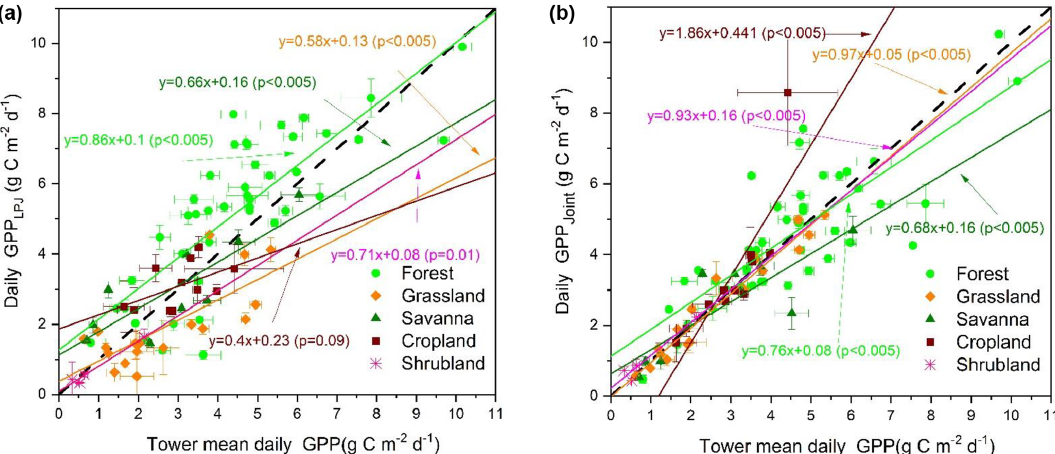
Figure 4. Scatter plots of daily GPP LPJ (a) and GPP joint (b) versus tower GPP for different PFTs.